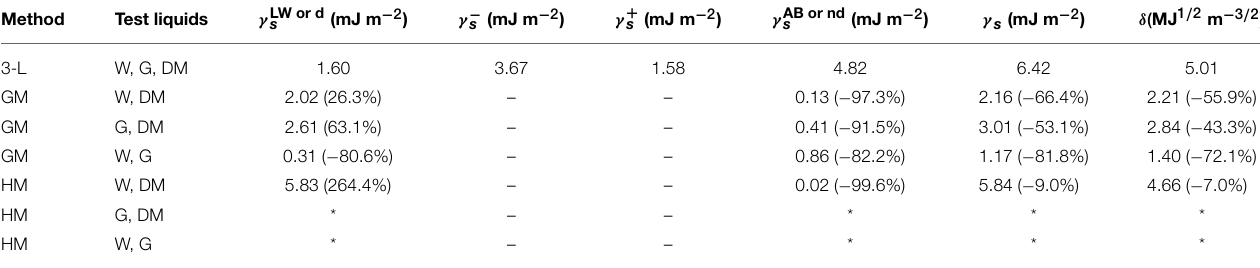
The deviation from the 3-L method is indicated in brackets. Values cannot be